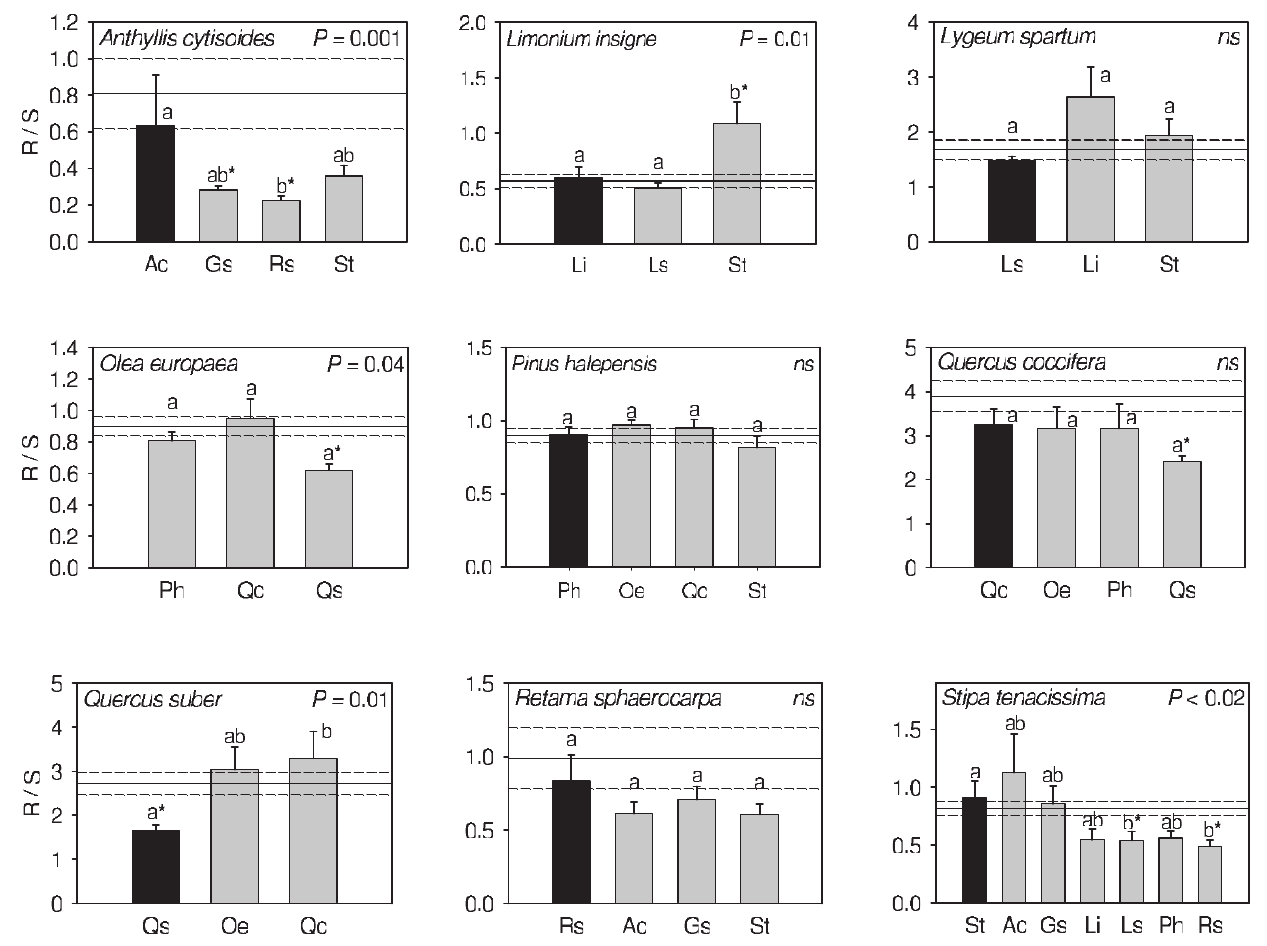
Figure 2. Root-to-shoot ratio of individuals of target species (name inside the panel) growing with individuals of the same (solid column) or different species (grey column). P is the significance of ANOVA ( ns : non-significant differences). The continuous horizontal line shows mean values of R:S ratio for control plants and dashed lines represent 6 1 SE. Bars with different letters are significantly different at P , 0.05. Asterisk denotes significant differences with control plants. Legend of species is as in Table 1.